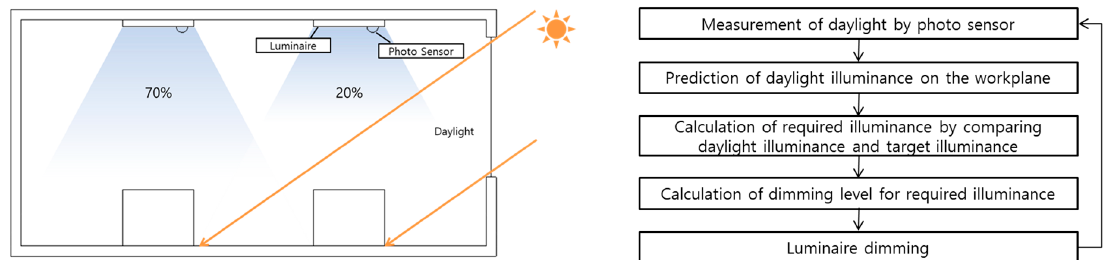
Figure 1. Concept of the daylight-responsive dimming system